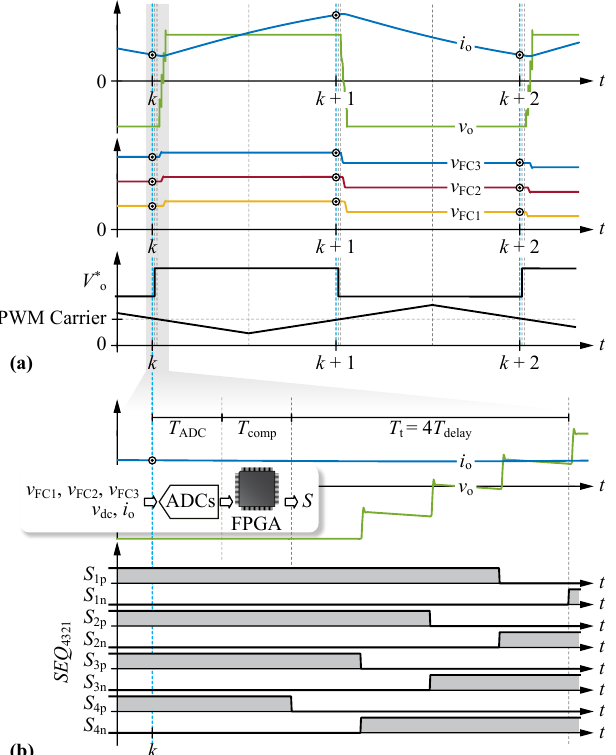
Figure 8. ( a ) Simulation results illustrating the PWM carrier, output voltage switching transition reference V * o and main waveforms. Note that the ADCs are triggered shortly before the switching transition. ( b ) Gate signals, output voltage and current waveforms at discrete time step k including the delay times introduced by the ADC conversion and FPGA